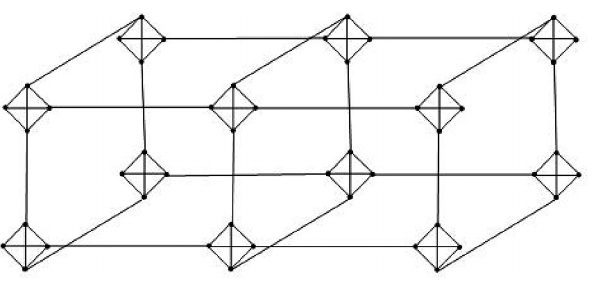
Figure 2: Hierarchical hypercube network (HNN-2)